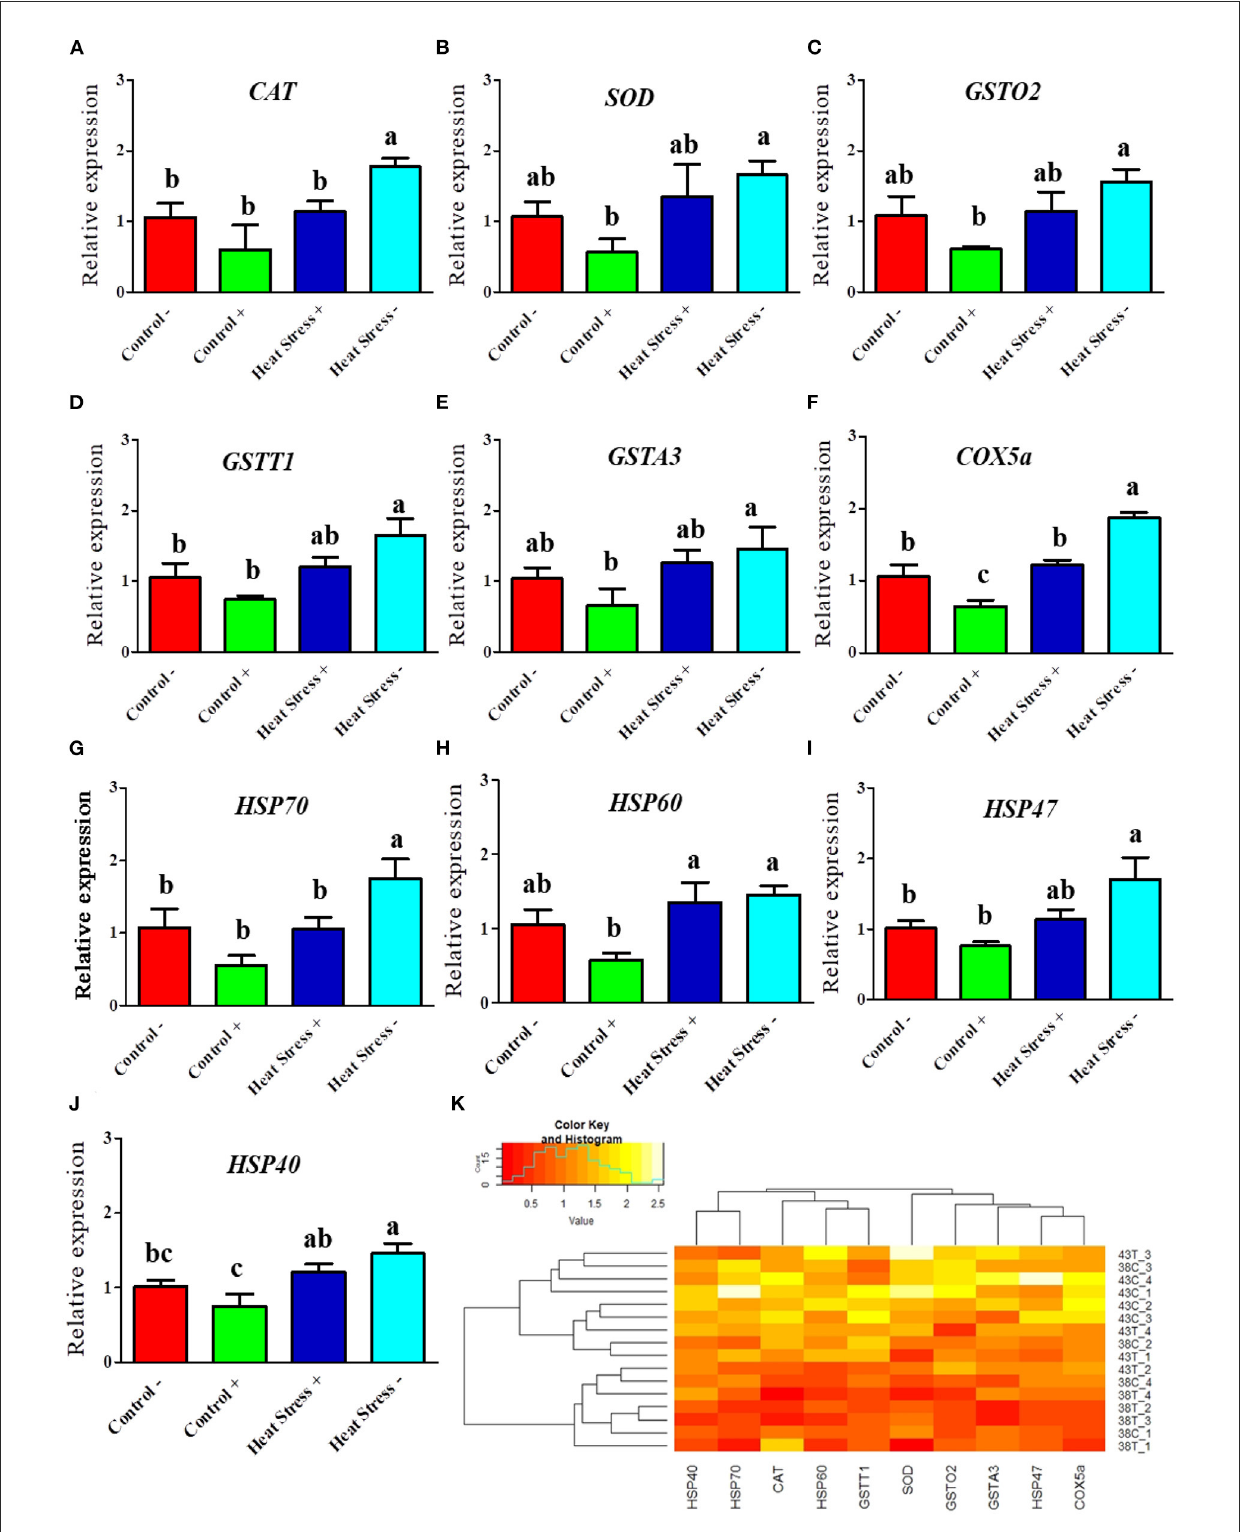
FIGURE4 Effects of COPA3 on mRNA expression levels of antioxidant enzymes and heat shock proteins. (A–J) Relative mRNA expression levels corresponding to the genes of catalase, superoxide dismutase, glutathione S-transferase omega-2, glutathione S-transferase theta 1, glutathione S-transferase A3, cytochrome c oxidase subunit 5a, heat shock protein70, heat shock protein 60, heat shock protein 47, and heat shock protein 40 obtained by RT-qPCR; data represent mean ± SE; a − c different letters indicate significant difference in different groups ( P < 0.05). (K) Cluster analysis of mRNA expression. Groups are distinguished by temperatures and COPA3 treatment, that is, fibroblasts at 38 ◦ C (Control- group), 38 ◦ C with COPA3 treatment (Control + group), 43 ◦ C with COPA3 treatment (Heat Stress + group), and 43 ◦ C temperature (Heat Stress- group). Each experiment was conducted in four biological replicates ( n =